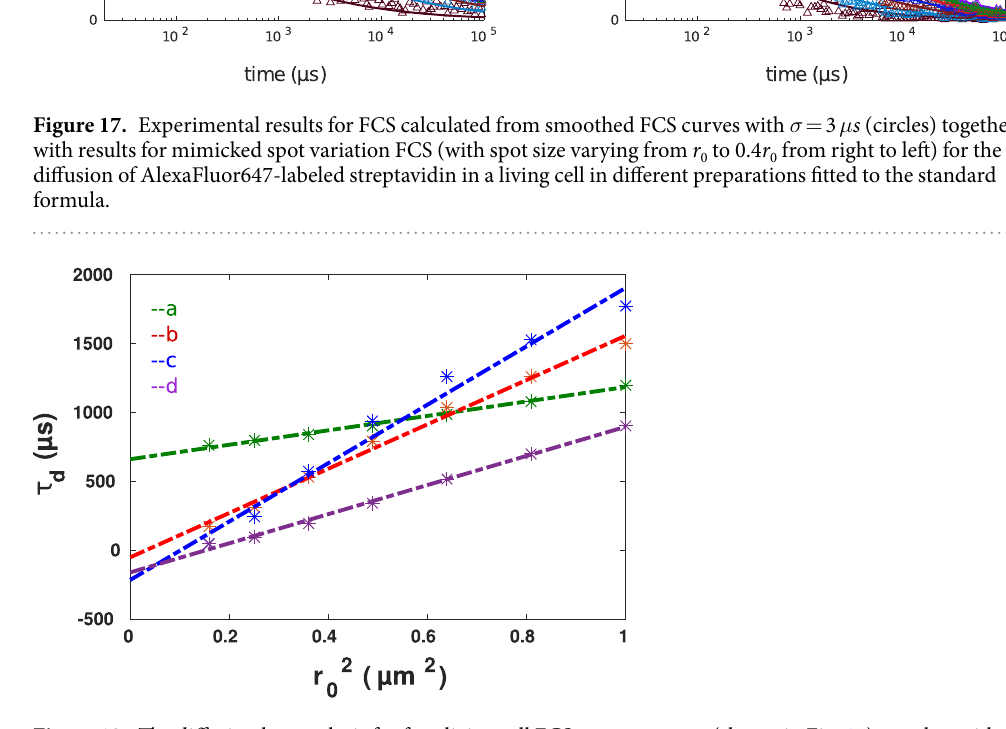
Figure 18. The diffusion law analysis for four living cell FCS measurements (shown in Fig. 17) together with the linear